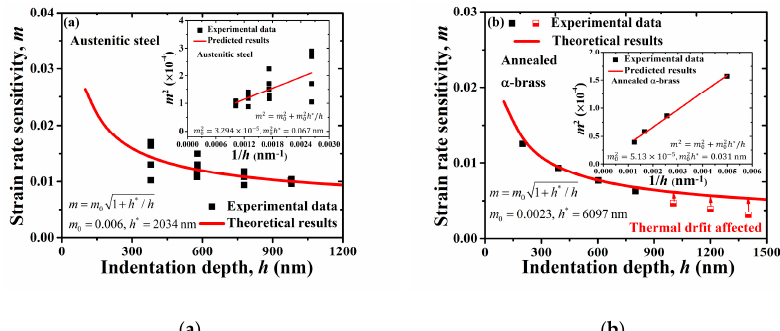
Figure 3. Strain rate sensitivity (cid:1865) -indentation depth ℎ relationships compared between the experimental data (black dots) and theoretical results (red lines) of ( a ) austenitic steel [38] and ( b ) annealed alpha brass [35]. The inset figure illustrates the calibration of model parameters by comparison with experimental data.